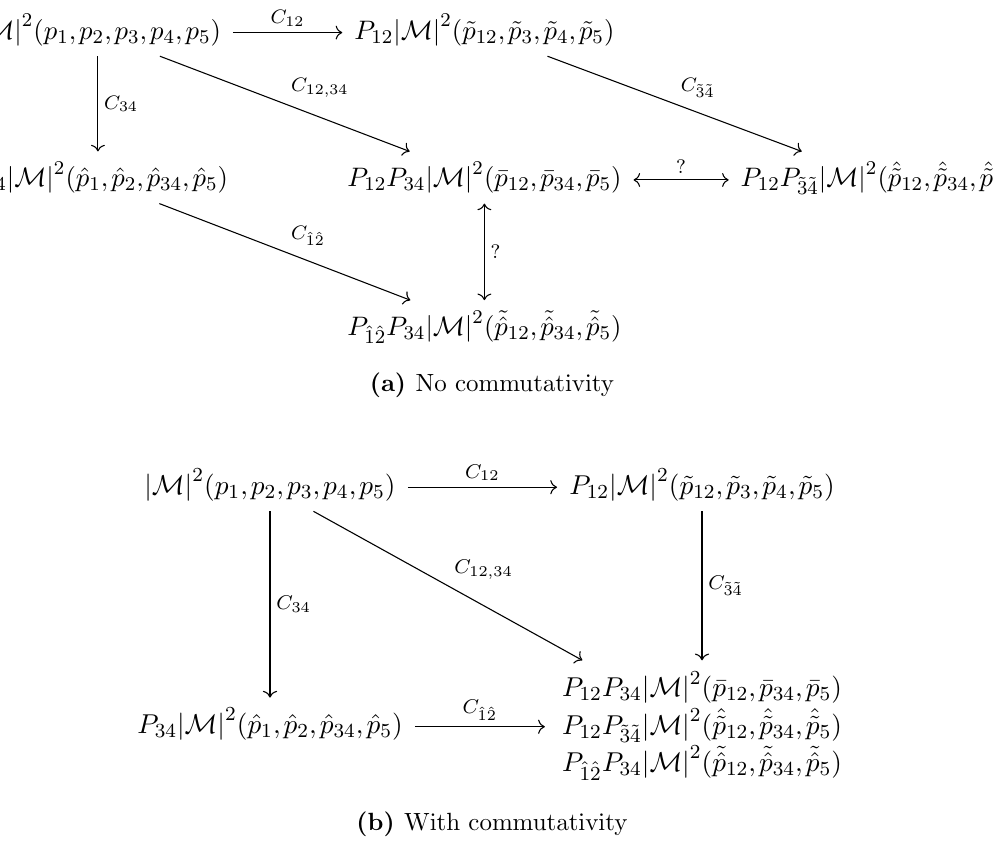
Figure 3. Comparison of the cancellation patterns of counterterms for the double collinear limit C 12 ; 34 and its collinear sub-limits in the case of a commuting and a not commuting